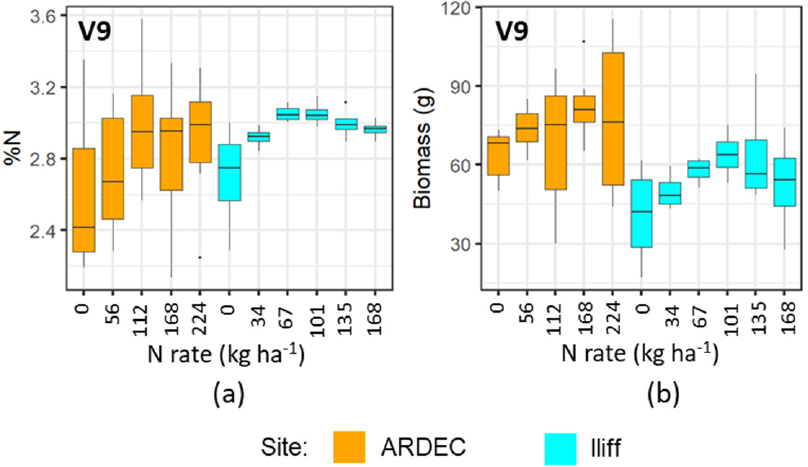
Figure 10. Variability of %N ( a ) and biomass ( b ) with different N rate applications at V9 growth stage of maize for two sites.